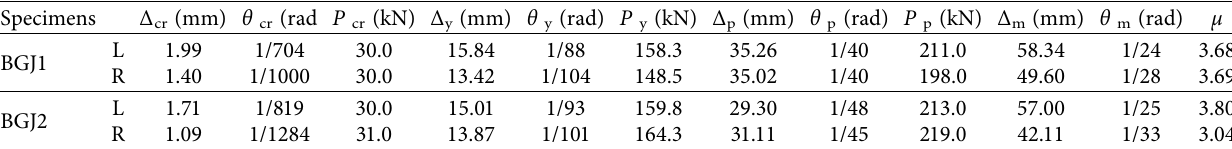
Table 2: Characteristic load and deflection of specimens.